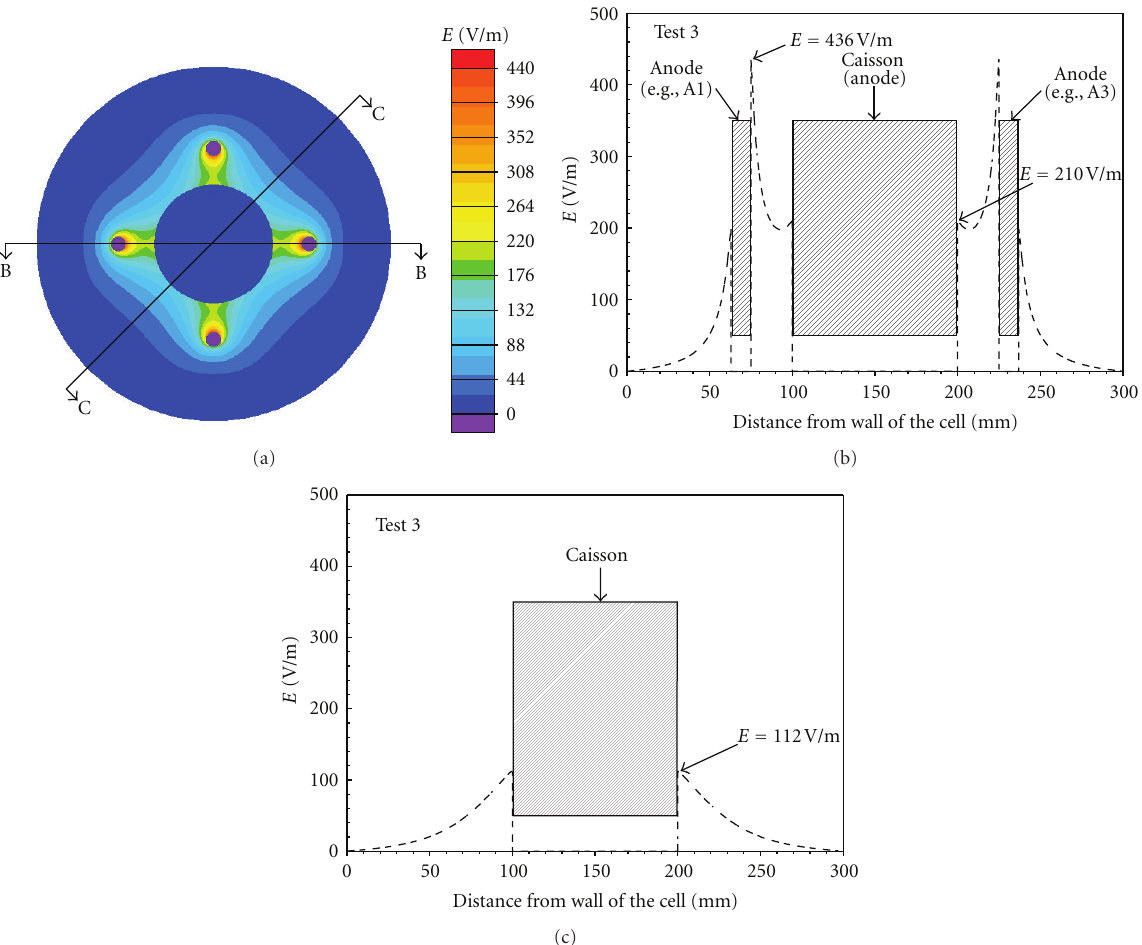
Figure 3: (a) Plan view of electric field intensity, E (V/m), distribution in the cell; (b) E along cross-section B-B of the cell; (c) E along cross-section C-C of the cell.